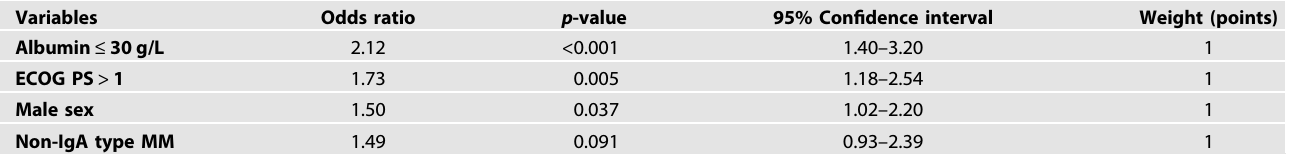
Table 4. Multivariate logistic regression analysis.